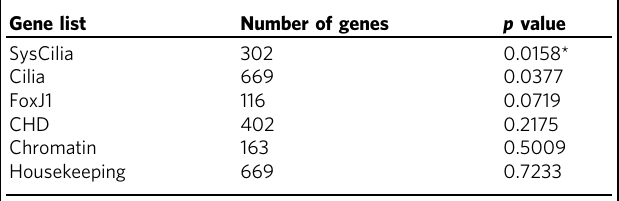
Table 2 Association of CHD probands and laterality defects by gene